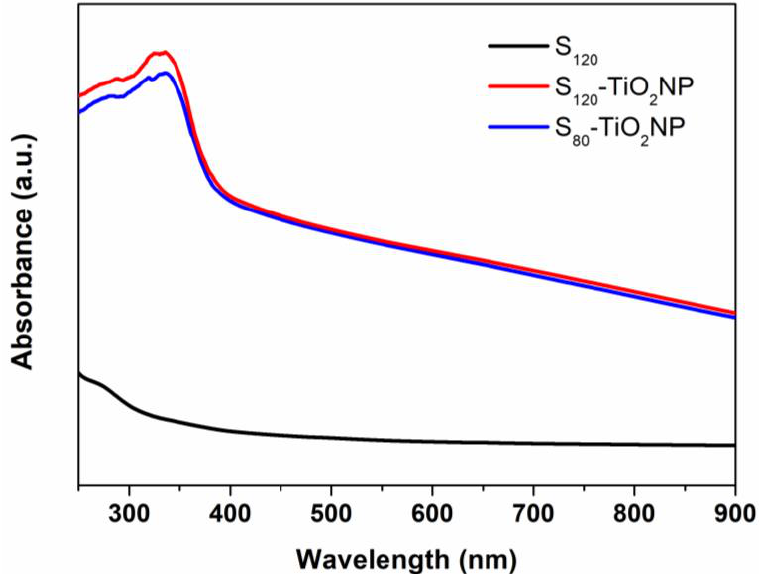
Figure 7. UV–vis absorption spectra of Starch and Starch/TiO 2 nanocomposite Figure 7. UV – vis absorption spectra of Starch and Starch/TiO2 nanocomposite films.